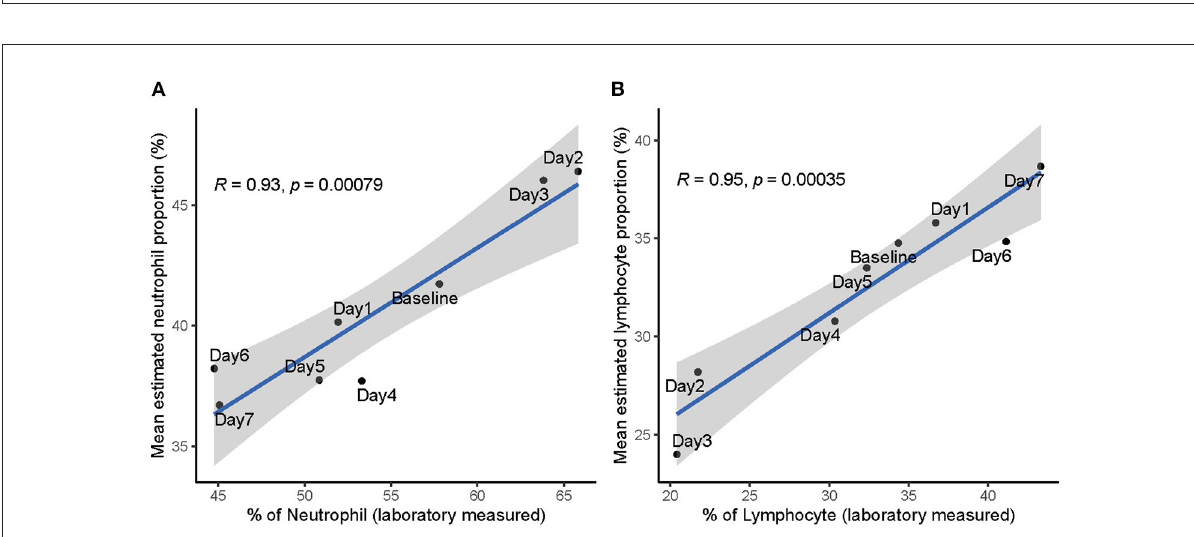
FIGURE7 Correlation between laboratory measured and estimated proportions of neutrophil (A) and lymphocyte (B) in SI group of influenza H3N2. Data points are labeled by the day post inoculation. Baseline represents prior to inoculation and day 1 represents the day of inoculation.